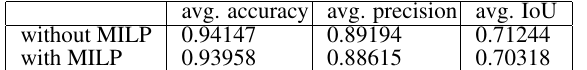
Figure 8. Alignment of windows that were detected on the 50 facade images of the ICG Graz50 collection.